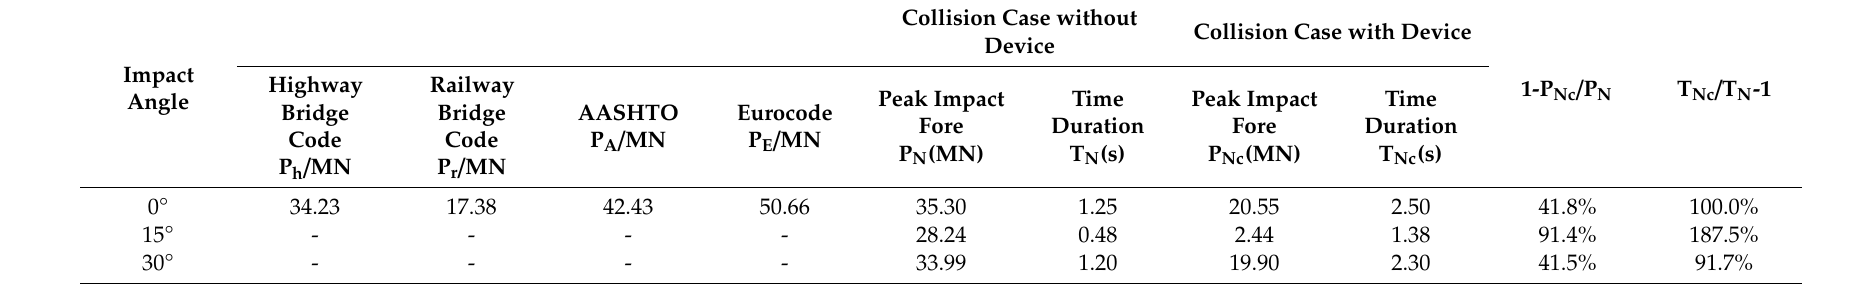
Table 4. Summary of the impact results under the three conditions and the di ff erent